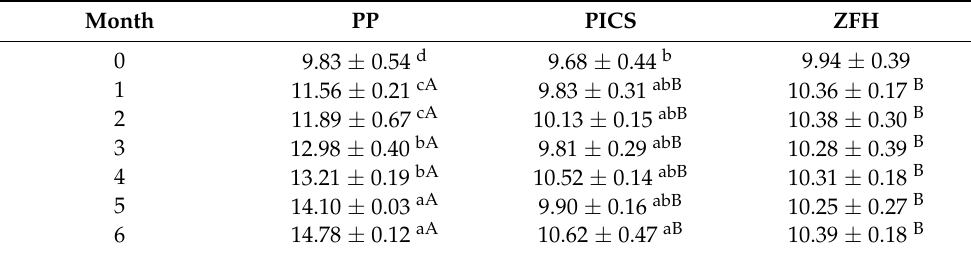
Table 5. Mean ( ± SE) levels of aflatoxin (ppb) of maize from Polypropylene (PP), Purdue Improved Crop Storage (PICS), and ZeroFly ® Hermetic (ZFH) bags sampled during the months of